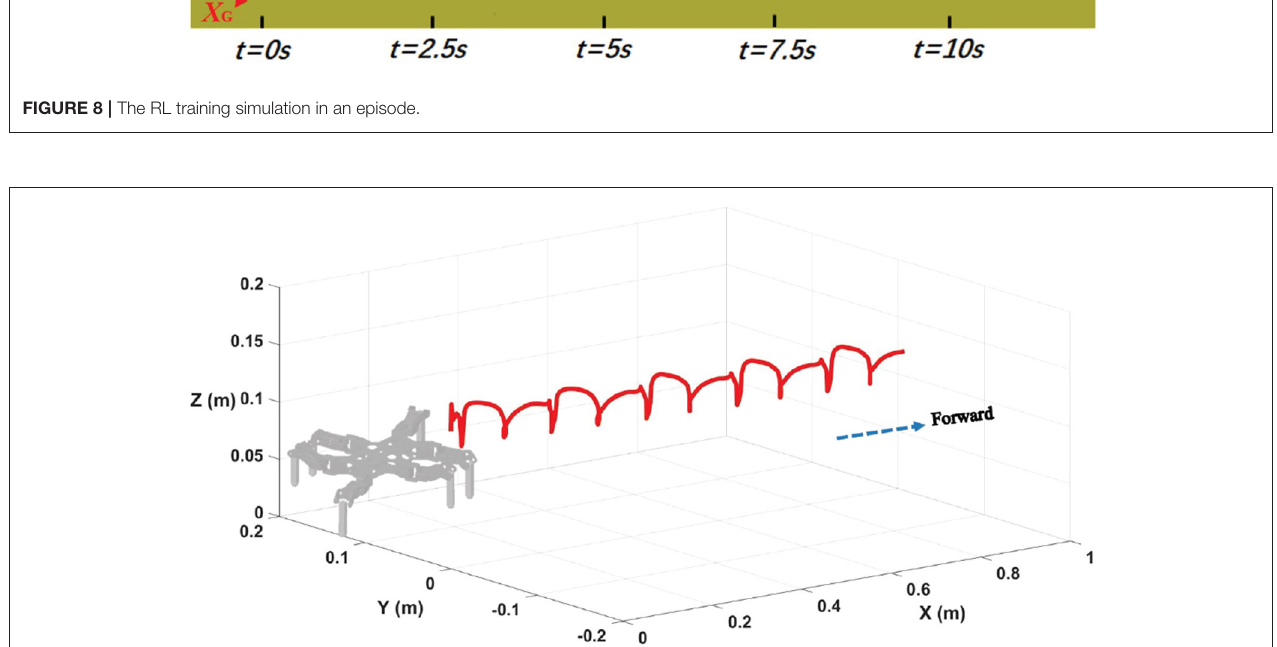
FIGURE 9 | The motion trajectory of the hexapod robot.